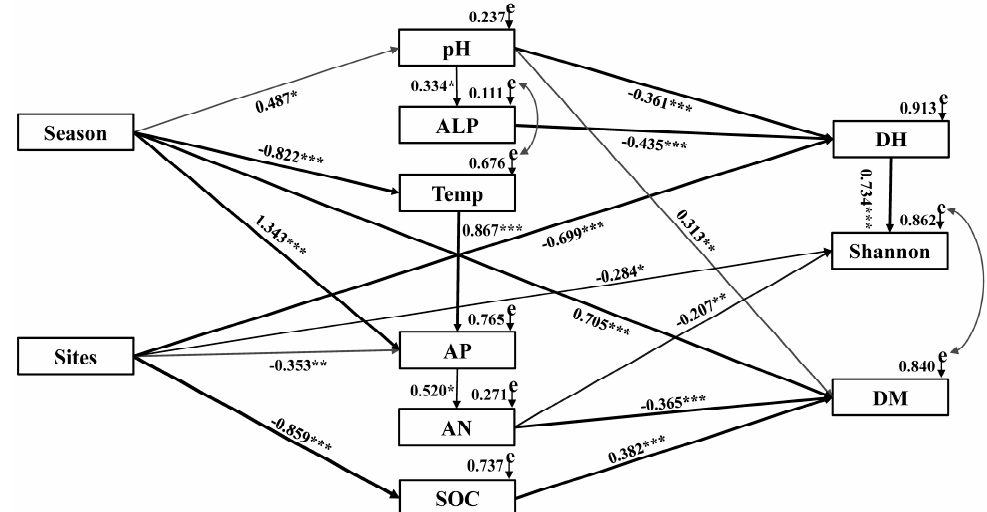
Figure 6. Structural equation model showing the causal relationships among different months, sites, edaphic factors, and DSE colonization. The final model fits the data well: maximum likelihood χ 2 = 46.384, df = 35, P = 0.094, goodness-of-fit index = 0.705, Akaike information criteria = 108.384, and root mean square error of approximation = 0.138. The numbers near the arrows indicate the standardized path coefficients, and the width of the solid lines indicates the strength of the causal effect (* p < 0.05, ** p < 0.01, and *** p < 0.001). ALP, alkaline phosphatase; AP, available phosphorus; AN, alkali-hydrolyzable nitrogen; SOC, soil organic carbon; Temp, temperature; DH, DSE hyphal colonization; DM, DSE microsclerotial colonization; Shannon, the Shannon–Wiener index; e, the values of residuals.